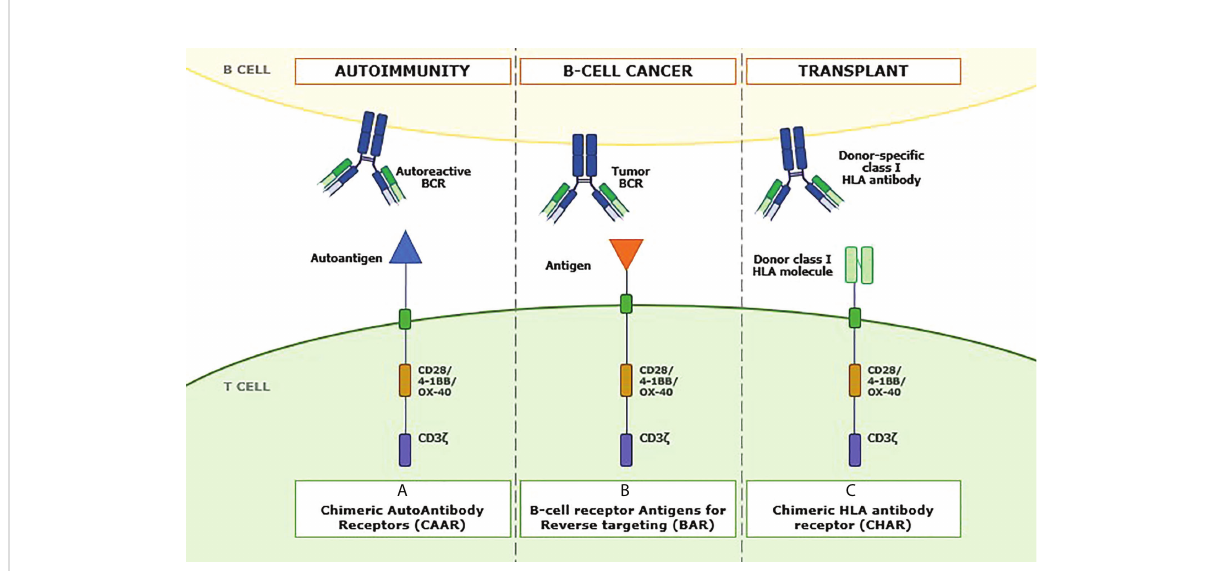
FIGURE 3 Role of ligands in other antibody-mediated diseases. Recently, new approaches have emerged in which different ligands linked to antibody-like structures can be used to address speci fi c pathologies. The sequence of these products shares similar domains to CAR-Ts but changes the extracellular domain. In panel (A) , a chimeric autoantibody receptor (CAAR) can be seen in which an autoantigen is incorporated as a recognition domain of the CAAR to redirect it toward autoantibodies on the autoreactive B-cell surface, thus facing autoimmune responses. Panel (B) shows the structure of a B-cell receptor antigen for reverse targeting (BAR). The recognition domain includes an antigen speci fi c to the single B-cell receptor (BCR) clonally speci fi c of each B-cell tumor. Finally, panel (C) represents an example of chimeric HLA antibody receptor (CHAR), where molecules of the class I HLA system replace the conventional recognition domain to direct the transduced T cell toward anti-HLA antibody-producing B cells to cope with posttransplant immune